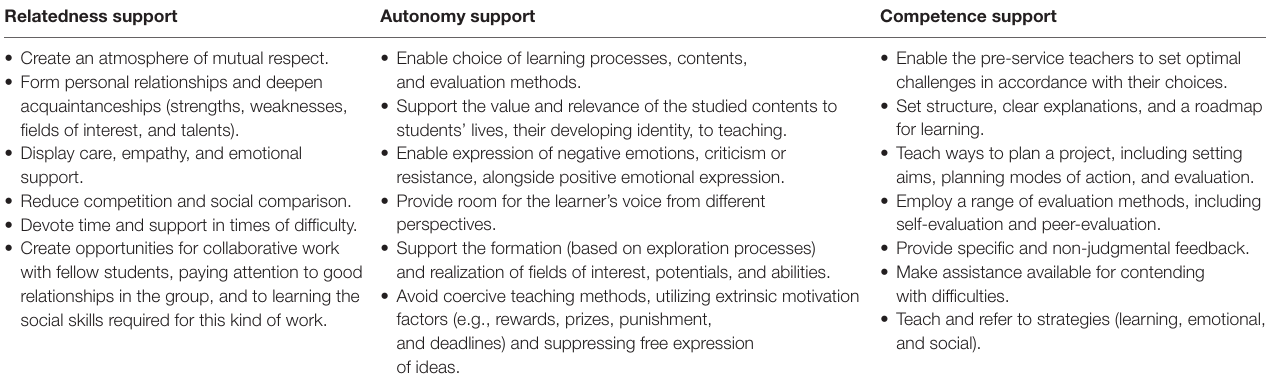
Table 4 | Self-determination theory as a core practice: some